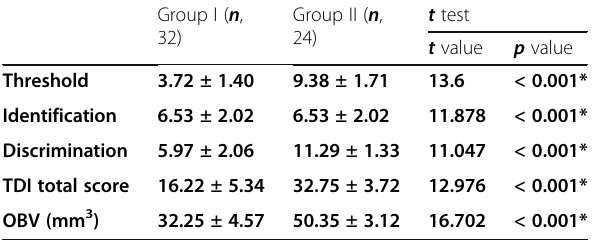
Table 1 Statistical analysis of olfactory performance among Parkinson disease patients (group I) and healthy control subjects (group II)